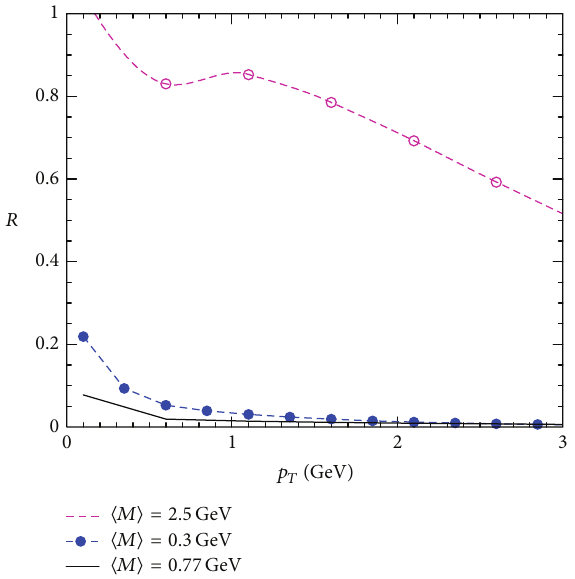
Figure 43: It shows the variation of 𝑅 𝑄 (see text) with 𝑝 𝑇 for ⟨𝑀⟩ = 0.3 GeV, 0.77 GeV and 2.5